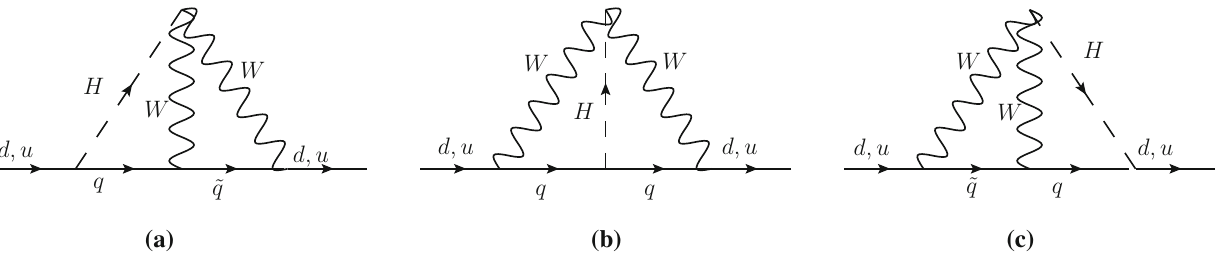
Fig. 4 Three diagrams with one WW H -Higgs coupling and one FC HiggscouplingforEDMsofa u -or d -quark.Softphotonemissionfrom one of the charged particles is assumed to be added. The ( b ) diagrams are zero in the limit of zero external momentum of the light quarks